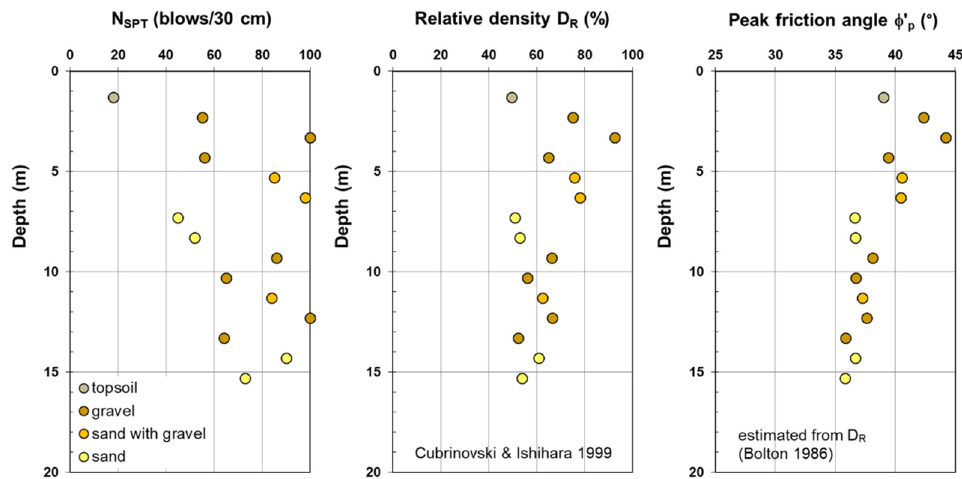
Figure 10. SPT-N blow counts and interpretation (borehole BH2).